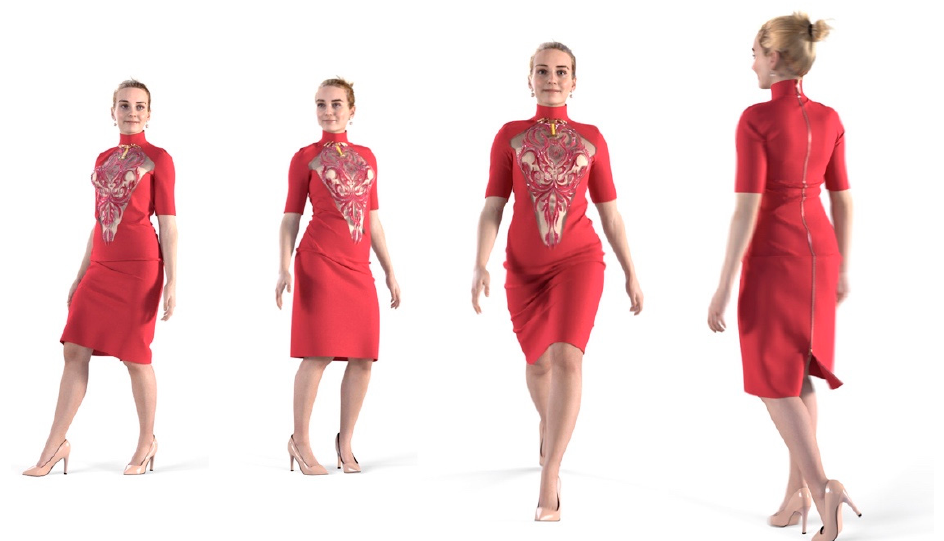
Figure 9. Virtual fashion: stills from an animated video rendered from 3D body scan and 3D garment model. (Courtesy Modern Mirror, Inc. New York, NY 10018, USA.; garment design by Noe Bernacelli.)